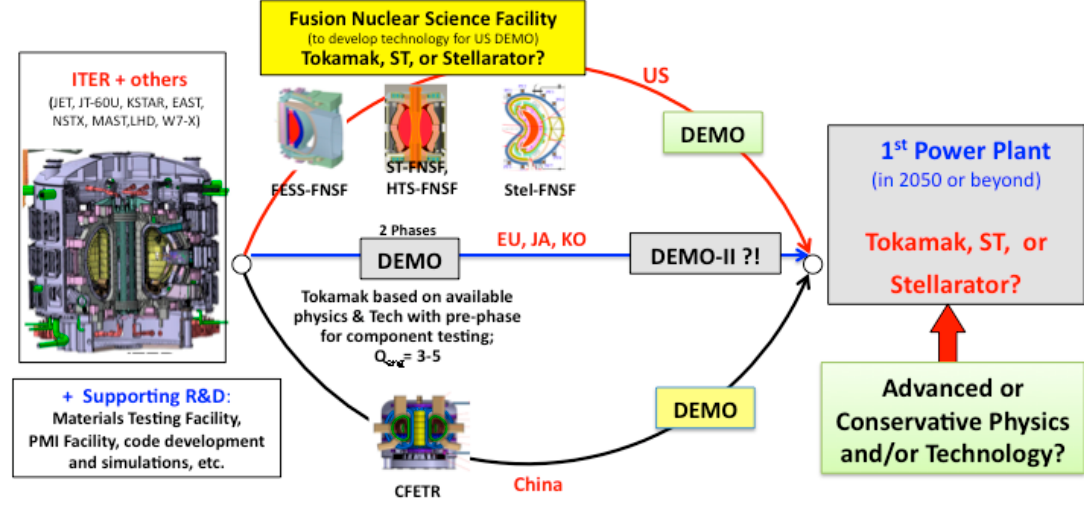
Figure 1. International pathways from the International Thermonuclear Experimental Reactor (ITER) to first fusion power plant.